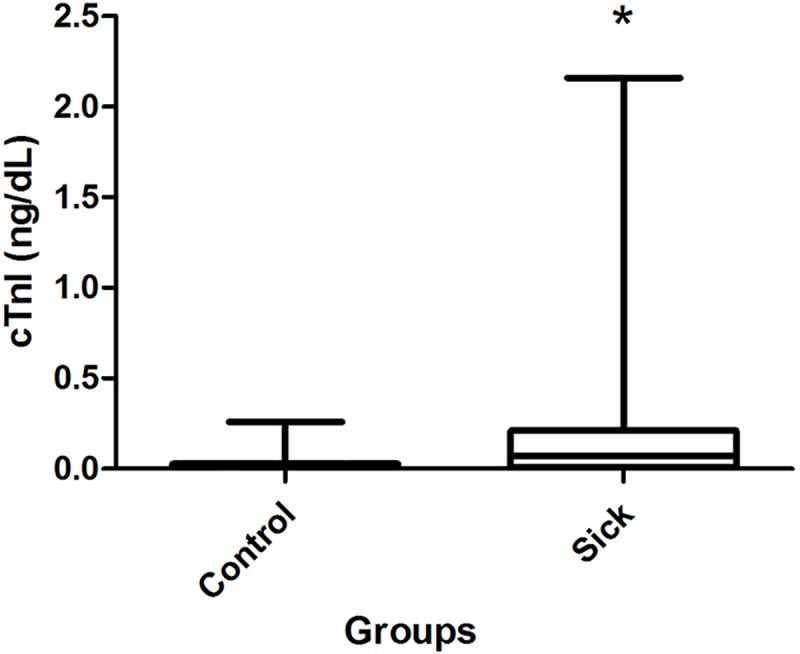
Sample distribution of cardiac Troponin I (ng/dL) concentrations between the groups with the results of the statistical test.